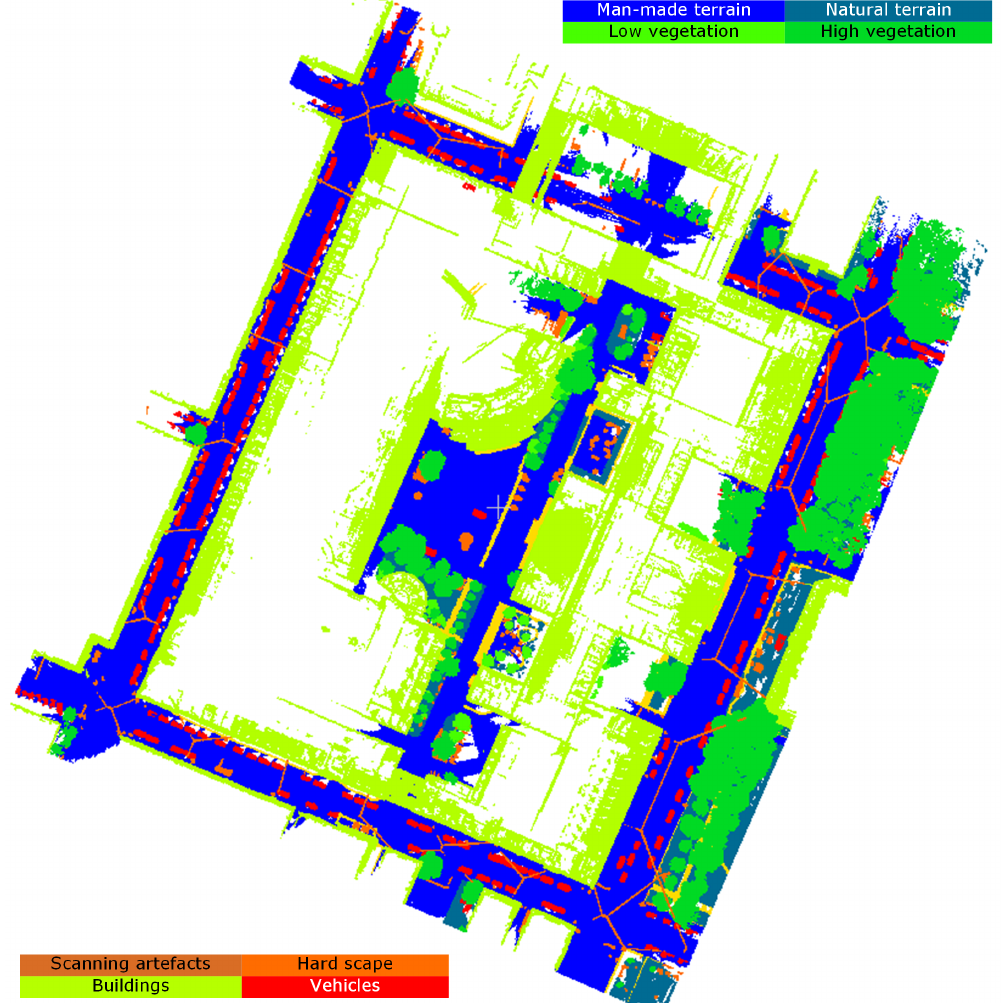
Figure 5. Benchmark dataset for semantic labeling with eight classes of